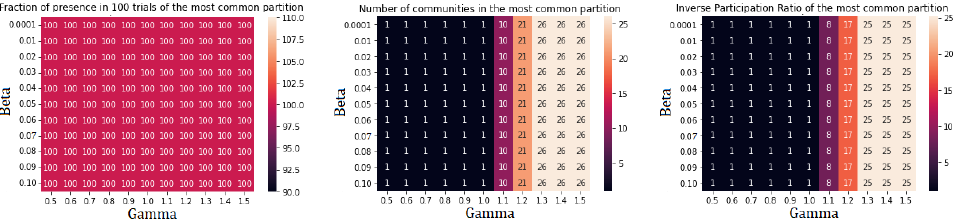
Figure A10. Performance indicators for Leiden algorithm applied to community II. There is no further